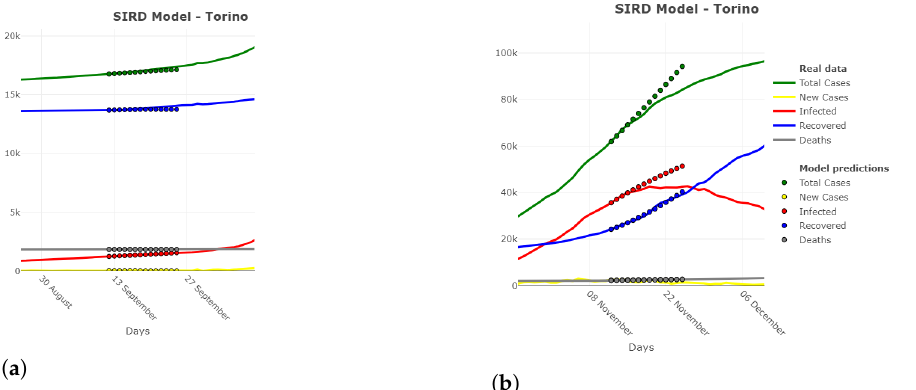
Figure 9. SIRD model predictions for Turin province using the STARMA model based on data up to September 10th and November 30th, 2020. ( a ) September 10th; ( b ) November